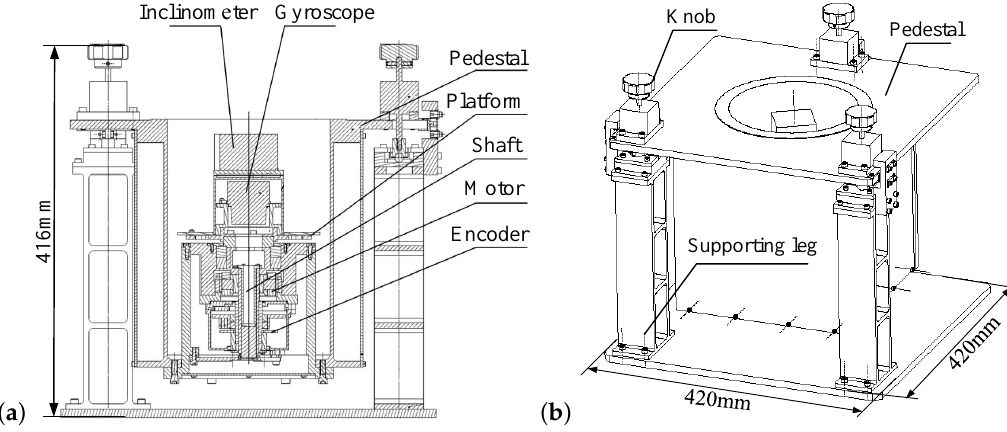
Figure 1. Layout of the north finder. ( a ) Inside part. ( b ) Outside part.